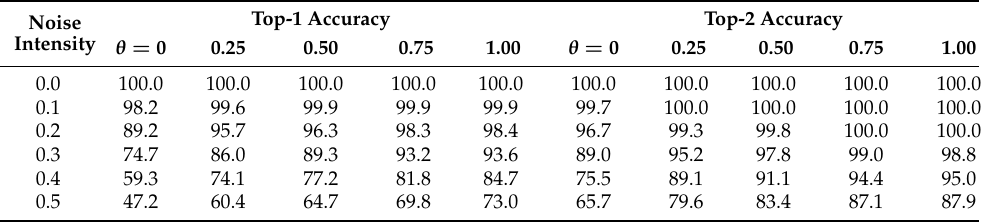
Table 3. Classification accuracy in Example 4 for different levels of Gaussian noise